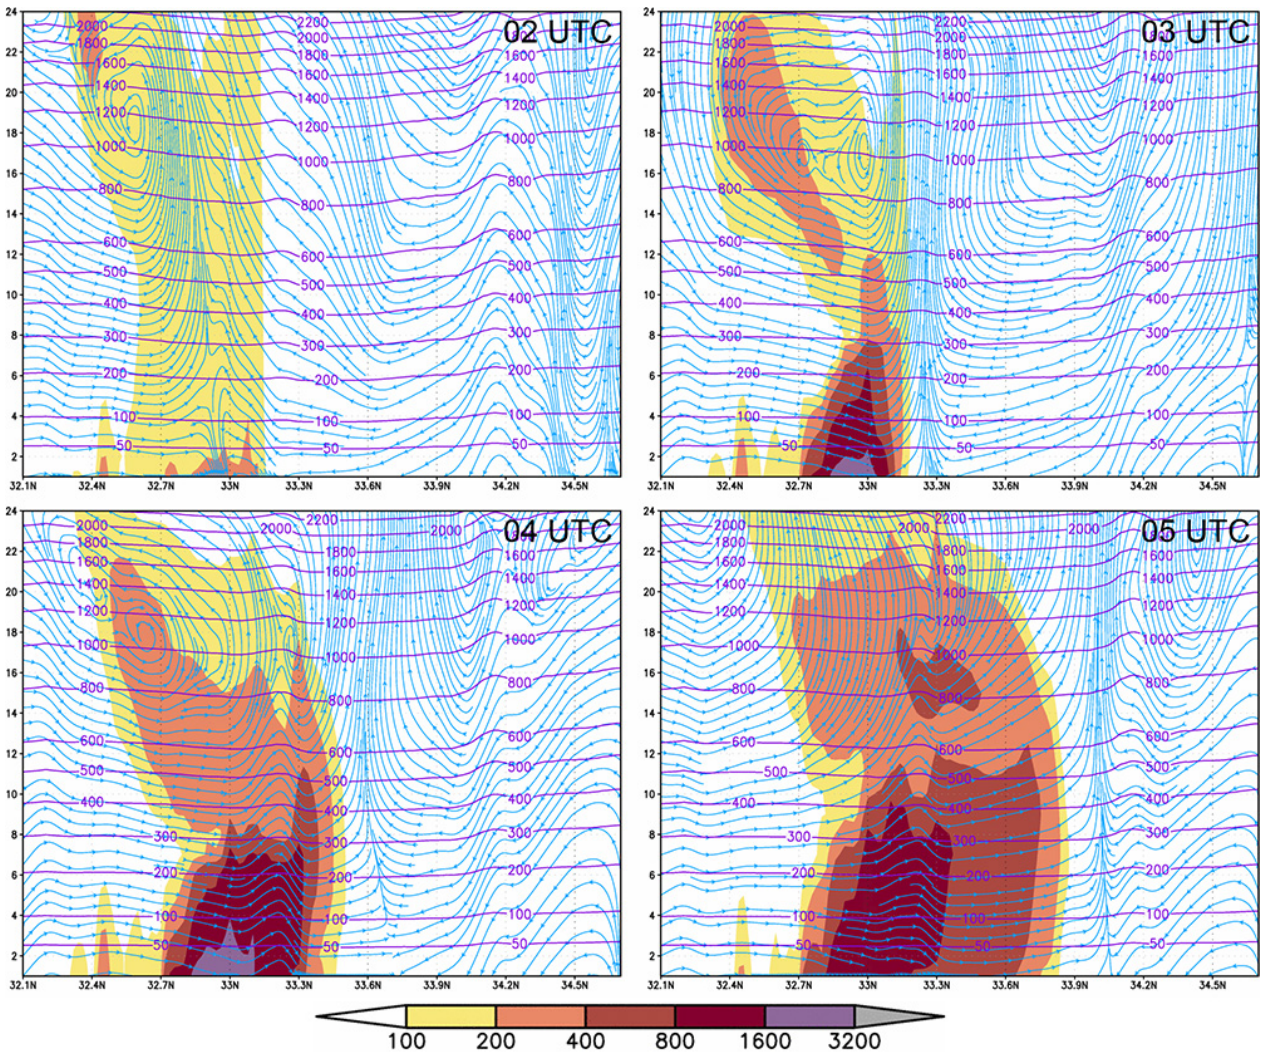
Fig. 7. NMME–DREAM vertical cross section along 112.2 ◦ W, PM 10 dust concentration, streamlines (blue), and height of model levels (purple lines) at 02:00 (upper left), 03:00 (upper right), 04:00 (lower left), and 05:00 (lower right) UTC, respectively, 6 July